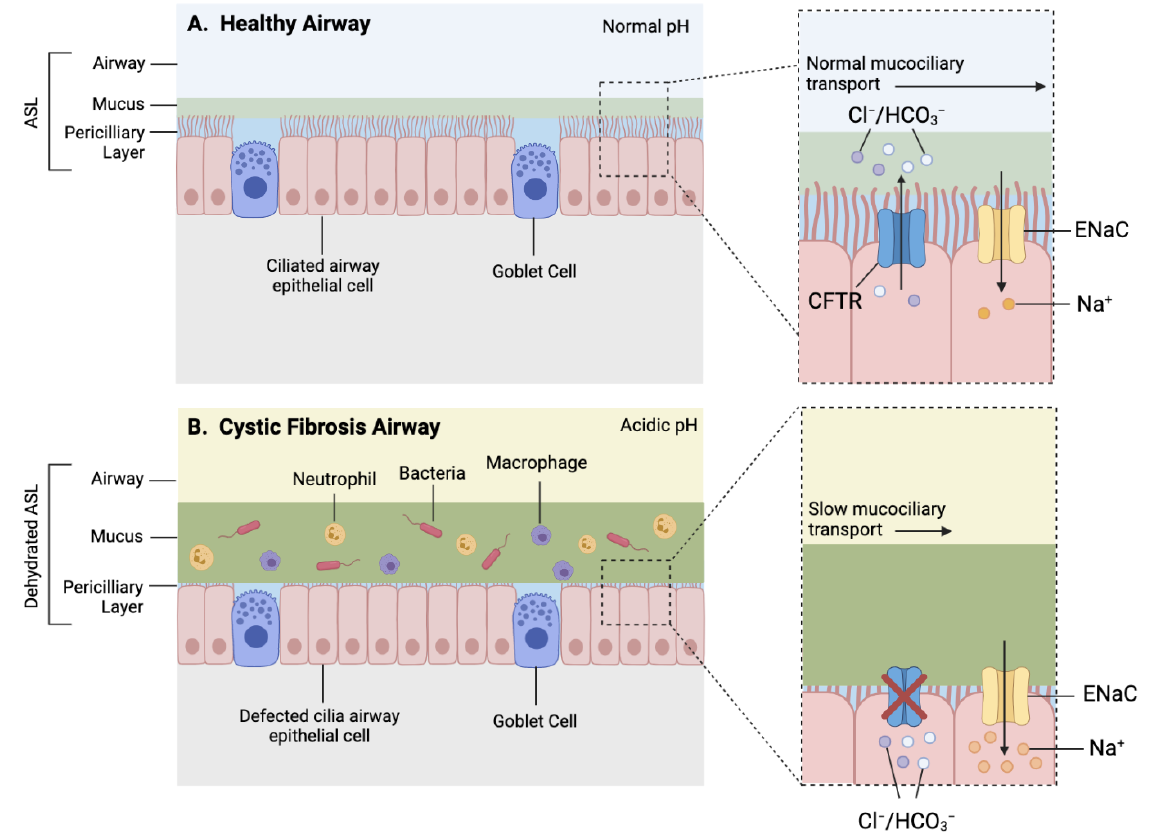
Figure 2. Simplified schematic of a healthy and CF airway. ( A ) Normal functioning CFTR channel in healthy airway enables efficient Chloride (Cl − ) and bicarbonate (HCO 3 − ) transport, as well as regulated sodium (Na + ) reabsorption through epithelial sodium channel (ENaC), resulting in homeostatic airway microenvironment, with appropriate pH, airway surface liquid (ASL) hydration and mucus viscosity, promoting efficient mucociliary transport. ( B ) Dysfunctional CFTR protein in cystic fibrosis airway results in inhibited chloride and bicarbonate ion transport and increased sodium reabsorption which leads to reduced volume of periciliary layer, increased viscosity of mucus layer and acidic airway microenvironment contributing to mucostasis and inefficient mucociliary transport. Increased mucus viscosity promotes mucus plugging in submucosal gland, further preventing mucus clearance (not shown). Reduced mucus clearance and acidic airway pH contribute to a pro-inflammatory airway microenvironment consisting of increased influx of inflammatory cells and accumulation of bacteria within mucus, accelerating